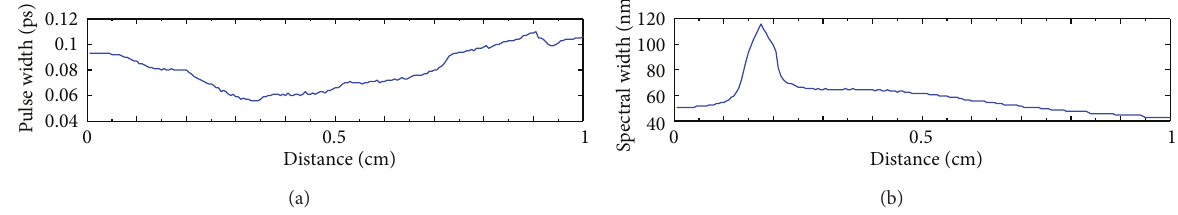
Figure 5: Results from numerical simulations showing (a) variation of pulse width along the silicon waveguide and (b) variation of spectral width along the silicon waveguide.